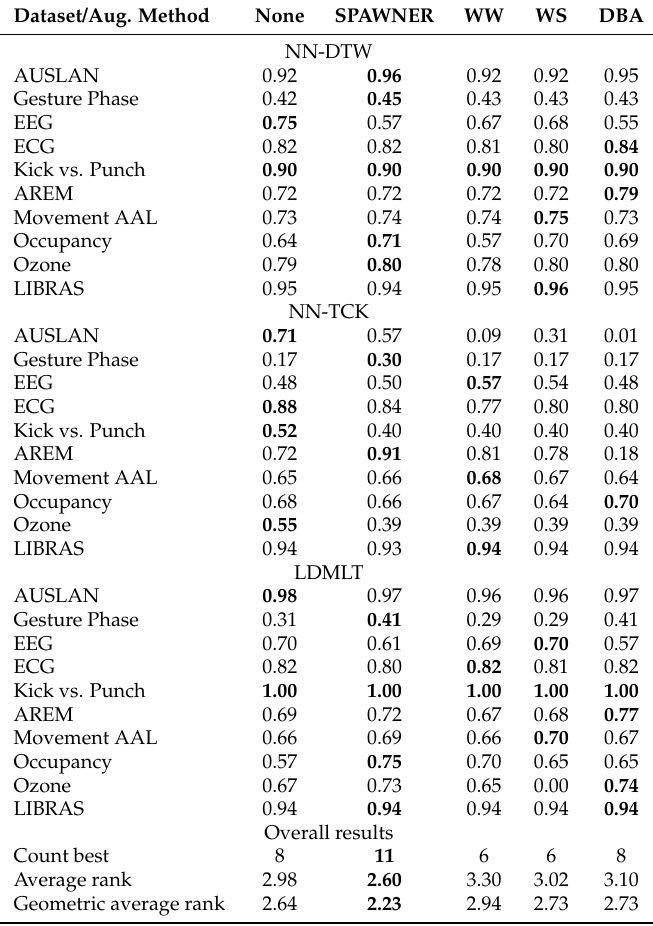
Table 2. Experimental comparison of augmentation methods using three time-series classifiers in terms of the classification accuracy. The greatest value used in the rank is written in bold and rounded to two significant